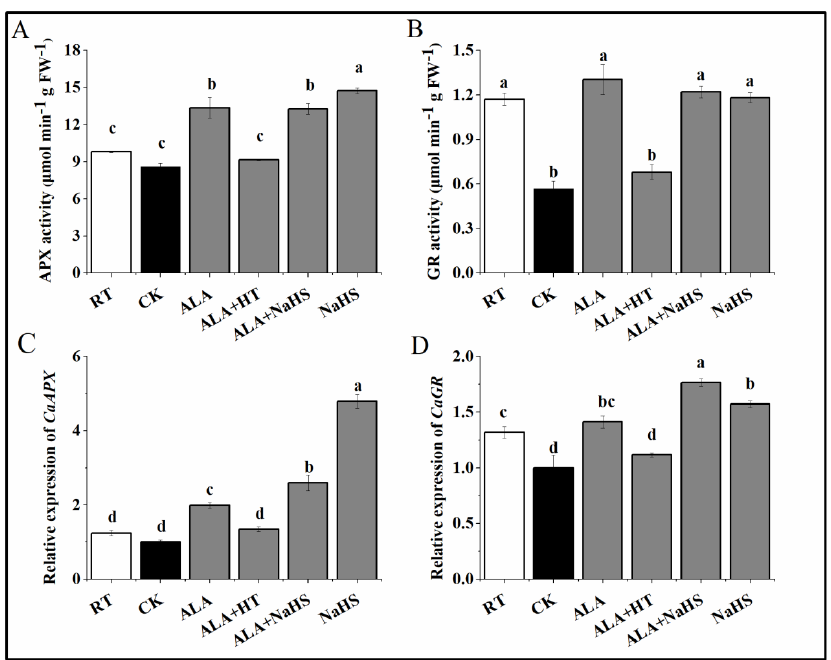
Figure 6. Effects of ALA and/or H 2 S on the activities of APX ( A ) and GR ( B ) and the relative expressions of CaAPX ( C ) and CaGR ( D ) under chilling stress for 24 h. The error bars are the standard errors for three independent tests. Different letters show significant differences ( p < 0.05) based on Duncan’s test.